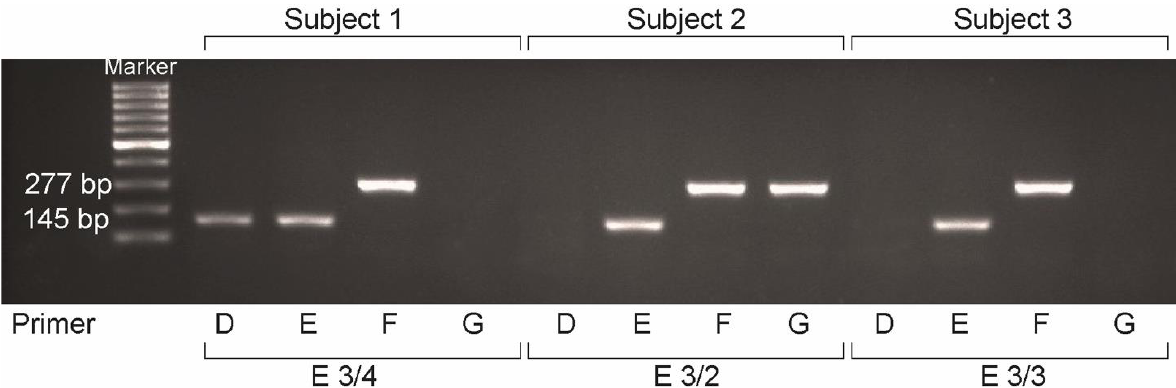
Figure 8. Apolipoprotein E genotyping using the polymerase chain reaction and allele specific oligonucleotide primers. Peqgreen-stained agarose gel showing the products from the PCR reactions. Lanes 1 through 4 are the reactions for subject 1: lane 1 is positive (primer D), lane 2 is positive (primer E), lane 3 is positive (primer F), and lane 4 is negative (primer G) indicating the E 3/4 genotype. Lanes 5 through 8 are the reactions for subject 2. Lane 5 (primer D) is negative, indicating the absence of the e4 allele; lanes 6 through 8 are positive with primers E, F, and G, indicating the presence of E3 and E2 yielding a genotype of apoE 3/2. Lanes 9 through 13 are the reactions for subject 3: lane l is negative (primer D), lane 2 is positive (primer E), lane 3 is positive (primer F), and lane 4 is negative (primer G) indicating the E 3/3 genotype. Table 7. The primer combination of every genotype. The E3/3 genotype yielding a 145 base pair